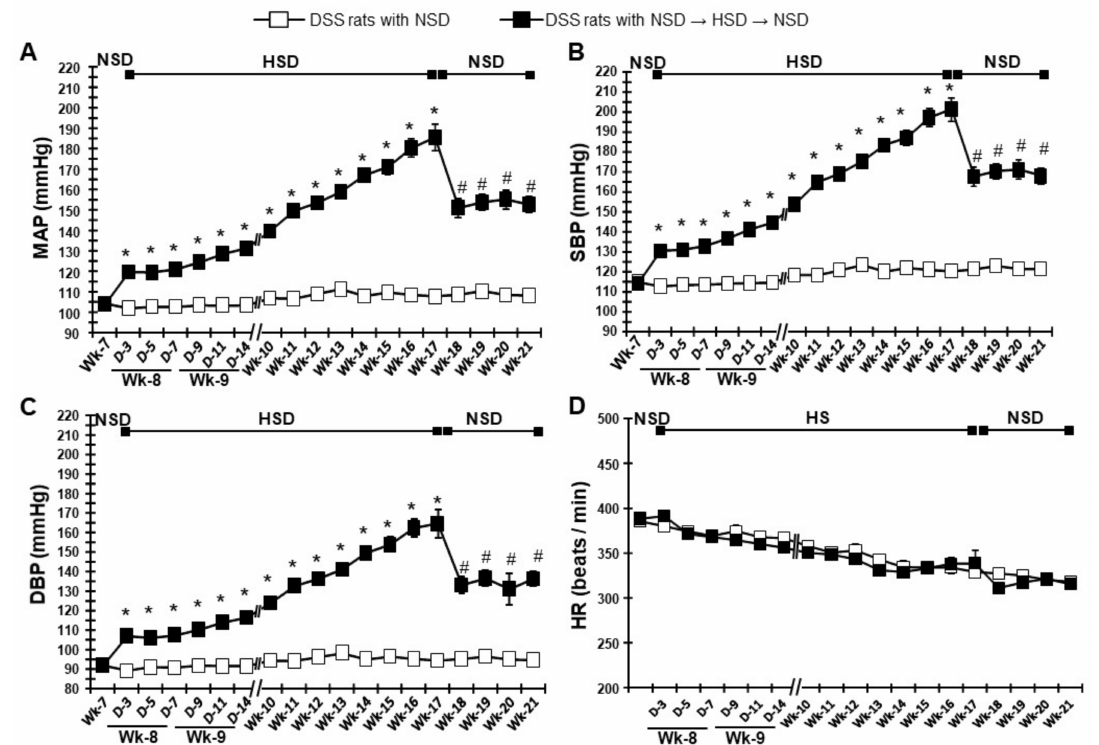
Figure 1. Time-dependent changes of blood pressure and heart rate. Averaged 20-h ( A ) mean arterial pressure (MAP), ( B ) systolic blood pressure (SBP), ( C ) diastolic blood pressure (DBP), and ( D ) heart rate (HR) during feeding normal salt diet (NSD, 0.3% NaCl, week 7), high salt diet (HSD, 8% NaCl, weeks 8–17), and again after switching to NSD (week 18–21) in Dahl salt-sensitive (DSS) rats. * p < 0.05 vs. DSS rats with NSD; # p < 0.05, DSS rats with NSD → HSD → NSD (week 17) vs. DSS rats with NSD → HSD → NSD (week